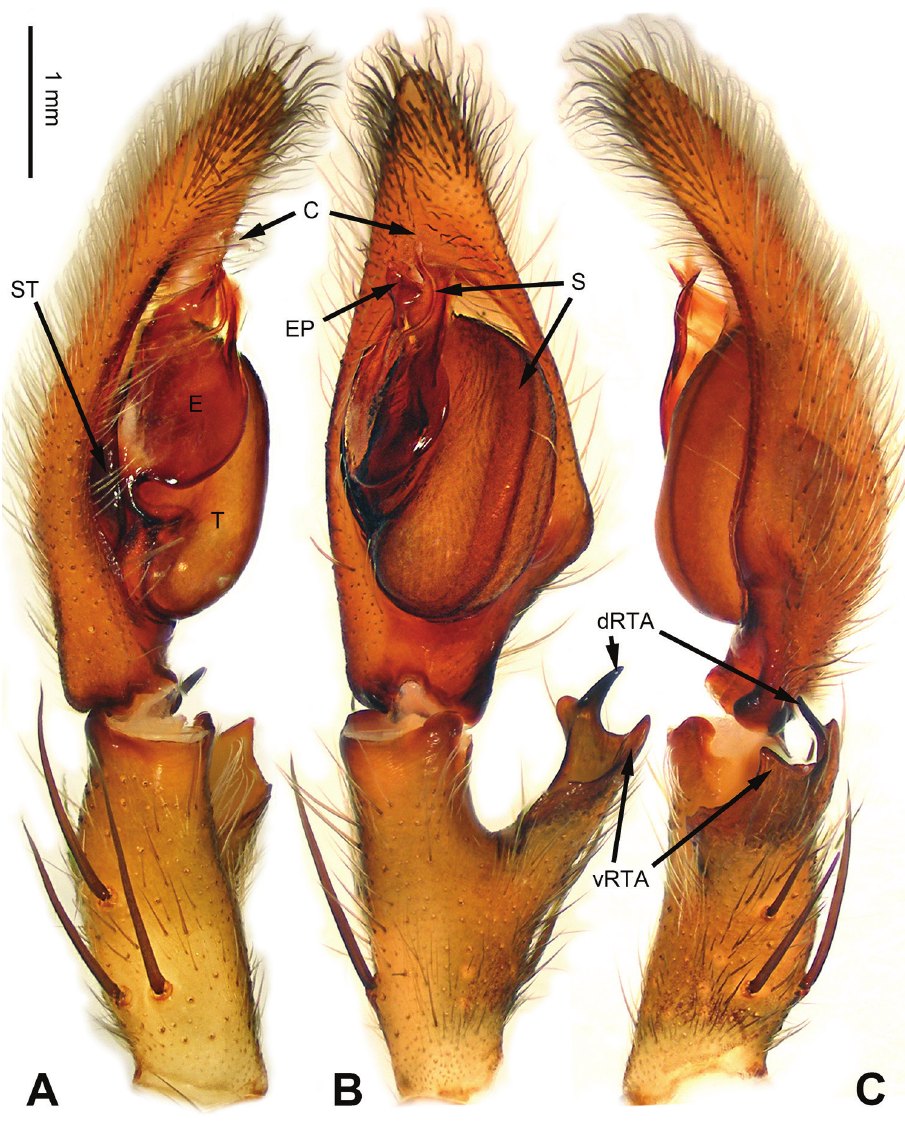
Figure 25. Pseudopoda subbirmanica Zhao & Li, sp. n., left palp of male holotype. A Prolateral view B Ven- tral view C Retrolateral view. Scale bar equal for A, B, C